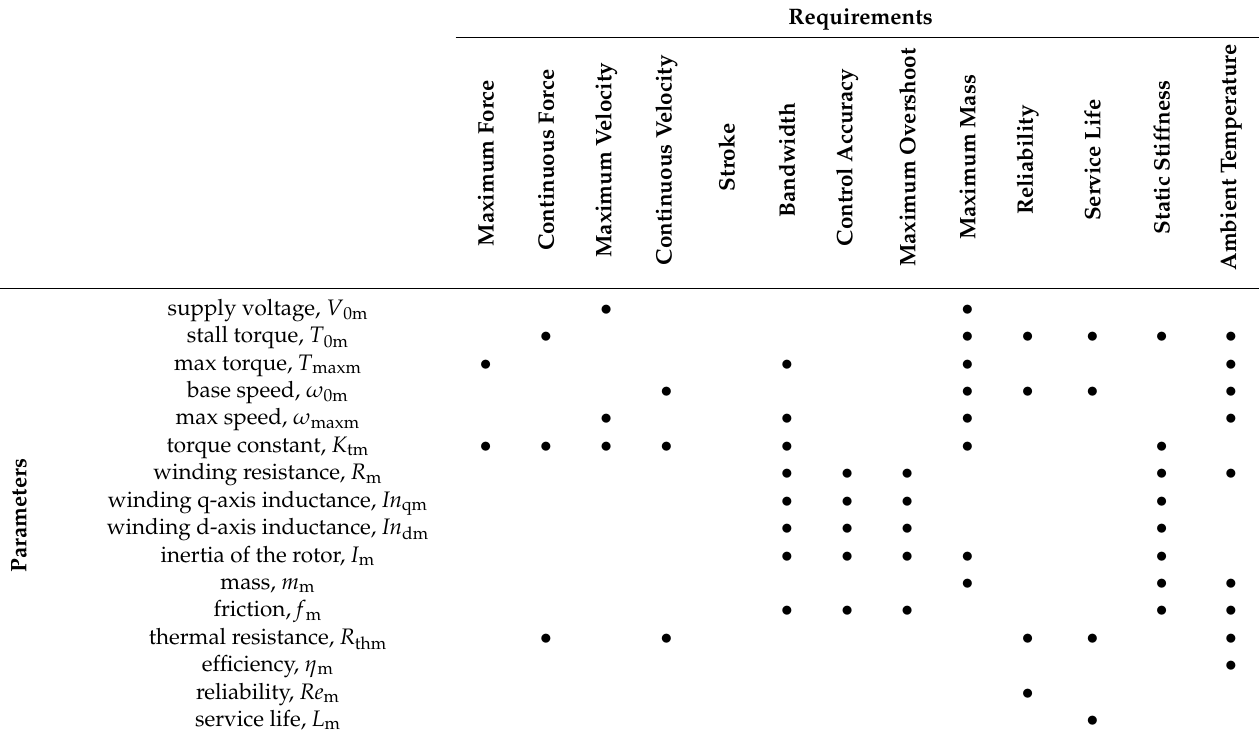
Table 2. The design parameter selection table of the EHA—the electric motor